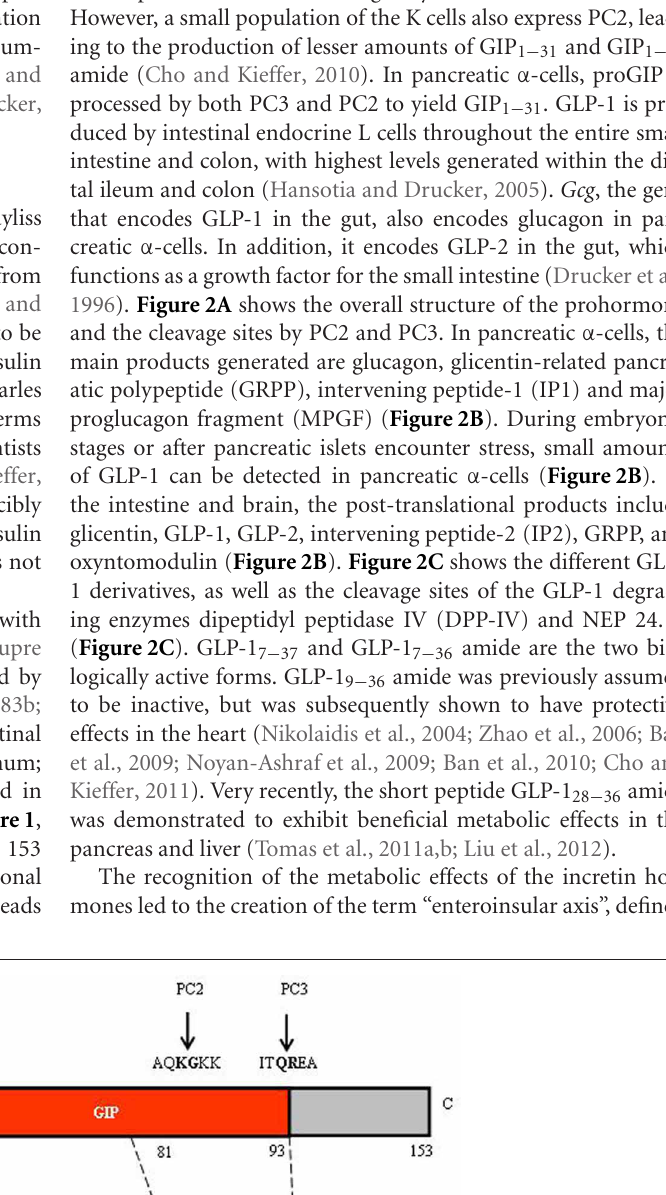
the intestinal K cells by the pro-hormone convertase PC3. In pancreatic α -cells and in a small portion of intestinal K cells, the cleavage by both PC2 and PC3 leads to the generation of GIP 1 − 30 (aa 52–93). SS, signal